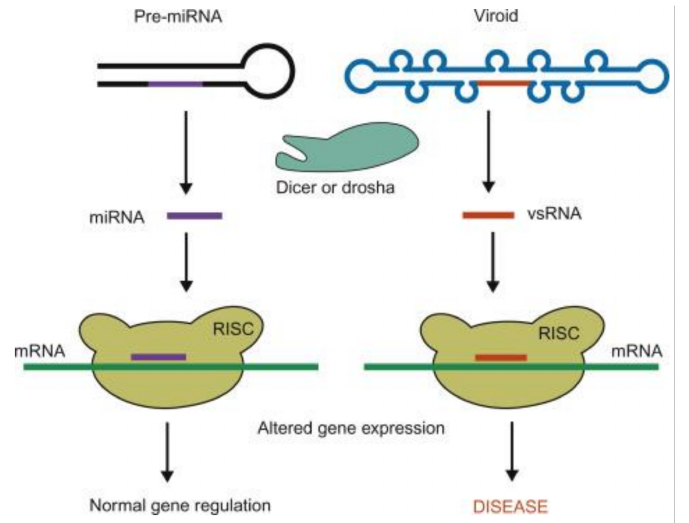
Figure 3. Viroids induce disease by generating viroid small RNA (vsRNA) that elicit RNA interference. (Adapted from Clark et al., 2019 [69]).